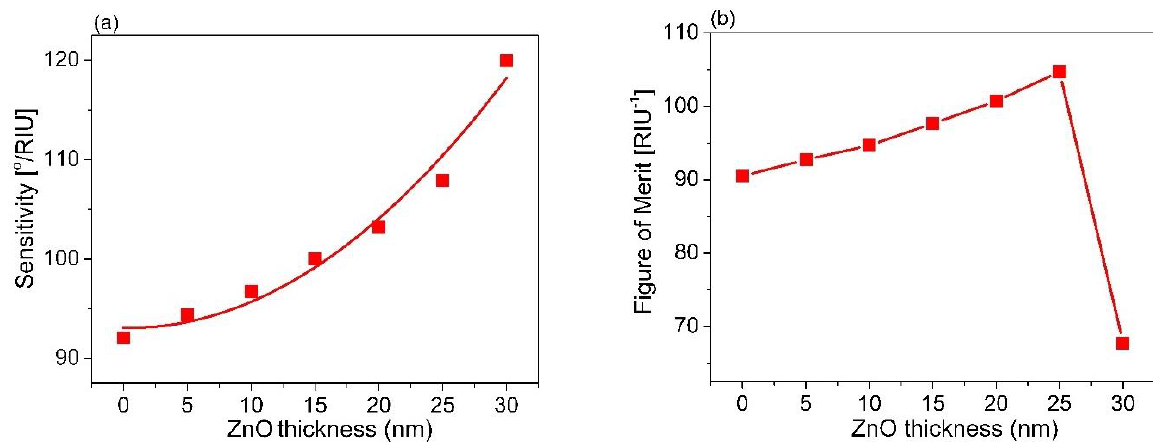
Figure 7. SPR spectra for varying thicknesses of ZnO based on the sensor structure of the BK7/TiO 2 /Ag/ZnO/sensing me- dium; ( b ) magnified view of ( a ); ( c ) the relationship between energy transfer and the ZnO thickness; ( d ) the change in resonance for different RI of the sensing medium based on the sensor structure of BK7/TiO 2 (140 nm)/Ag (60 nm)/ZnO (25 nm).